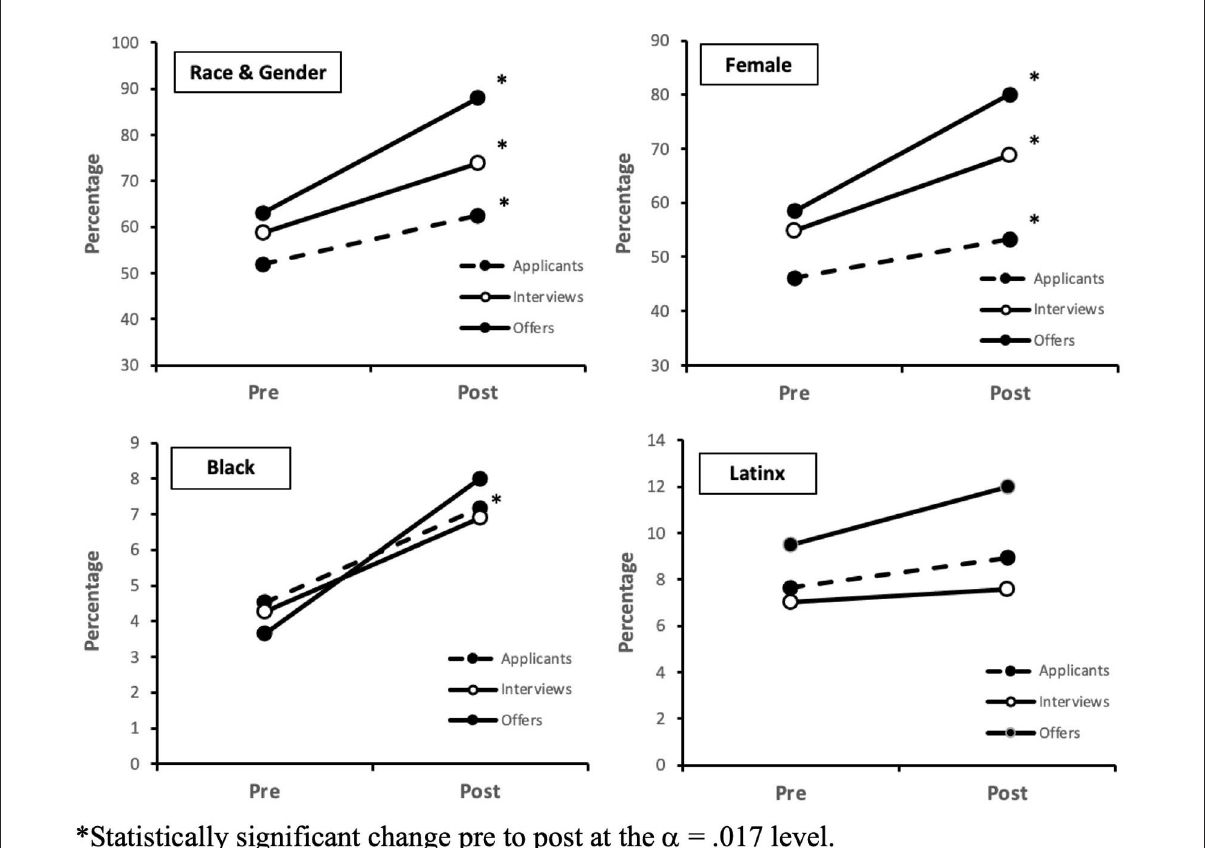
FIGURE1 Percentage of diverse individuals by category among applicants, interviewees, and offers. *Statistically significant change pre to post at the α = 0.017